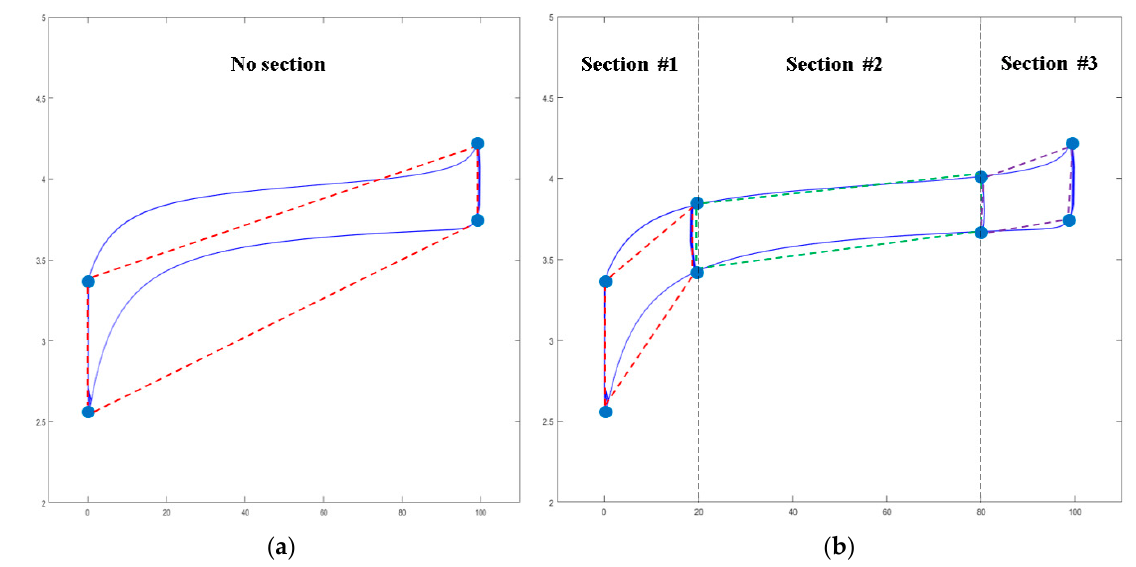
Figure 10. The concept of applying the section separation method: ( a ) the estimated Q value by PDM if the section separation method (SSM) is not applied and ( b ) the estimated Q value by PDM if SSM is